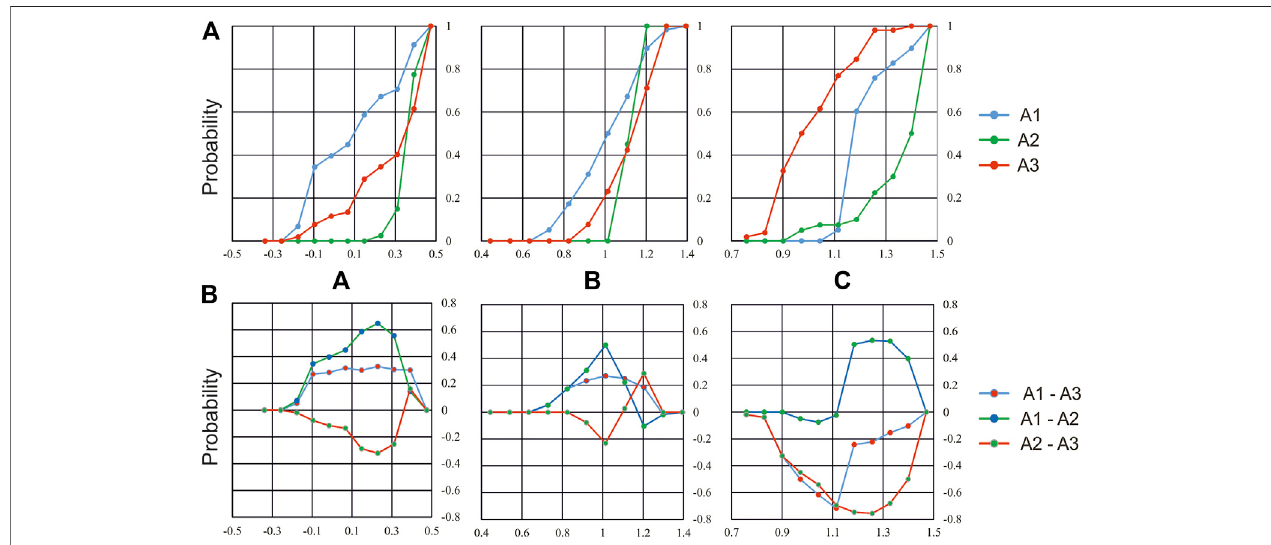
FIGURE 6 | Distribution of the USLE coef fi cients A, B and C, estimated for the fi ne scale grid in the three sub-regions A1, A2, A3: (A) the cumulative empirical probability functions F i ; (B) the pairwise differences F m ( coef ) and F n ( coef ), coef (cid:2) A, B, C.